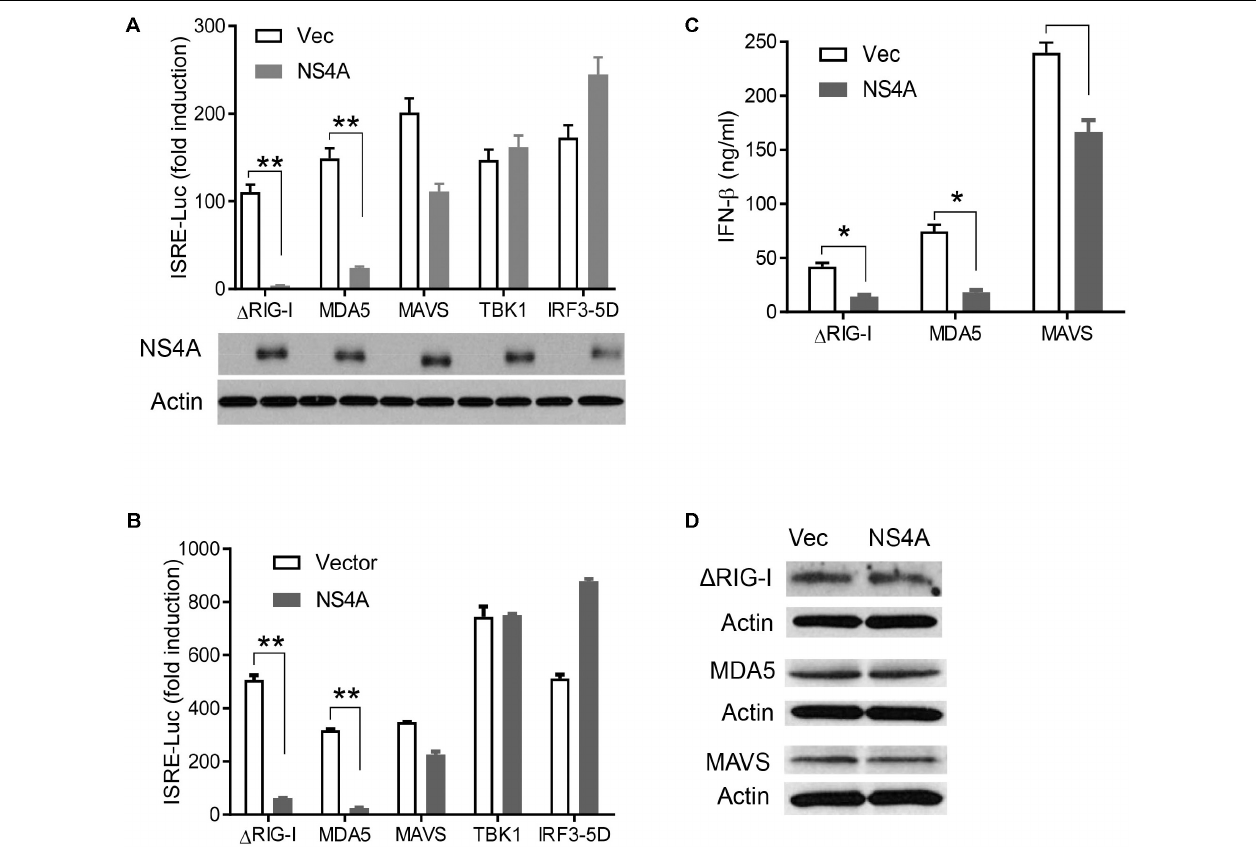
FIGURE 4 | NS4A interferes with RIG-I and MDA5-induced type I interferons. Quantification of ISRE-Luc activity in HEK293T cells transfected with 100 ng of FLAG vector or FLAG-NS4A of A ZIKV FS13025 and B FLR strain, together with the indicated individual immune genes of the RLR pathway for 24 h. The immunoblots under the bar graph show the FLAG-NS4A and actin protein expression. (C) Quantification of type I IFN bioavailability in the culture media of A . (D) Immunoblots of FLAG- (cid:49) RIG-I, MDA5, and MAVS proteins in HEK293T cells treated exactly as in A . The FLAG-tagged protein was detected with an anti-FLAG antibody. The bars in A–C represent the mean + SEM of the results, n = 3. ∗ p < 0.0.5; ∗∗ p < 0.01 (Student’s t -test). The data shown are representative of three independent